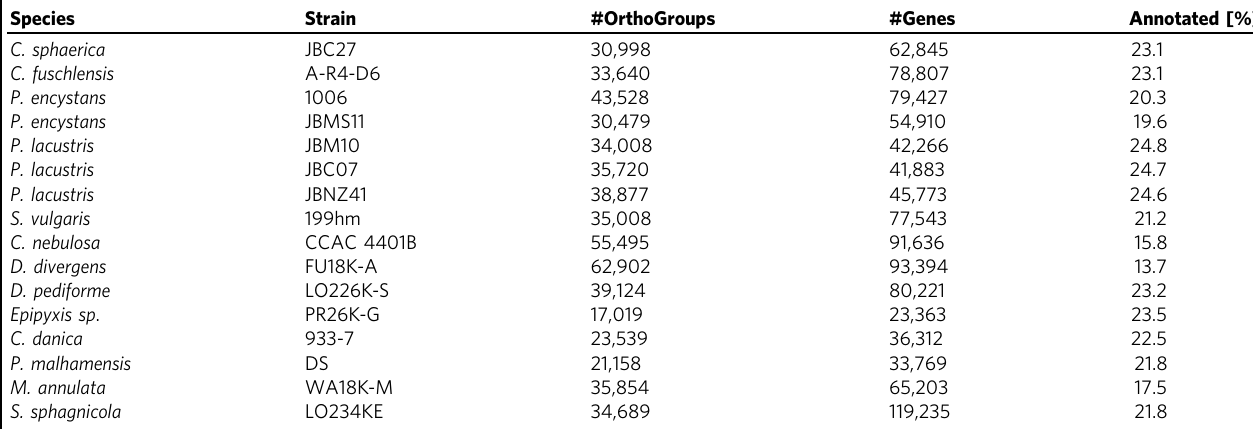
Table 4 Gene prediction and orthologous groups.